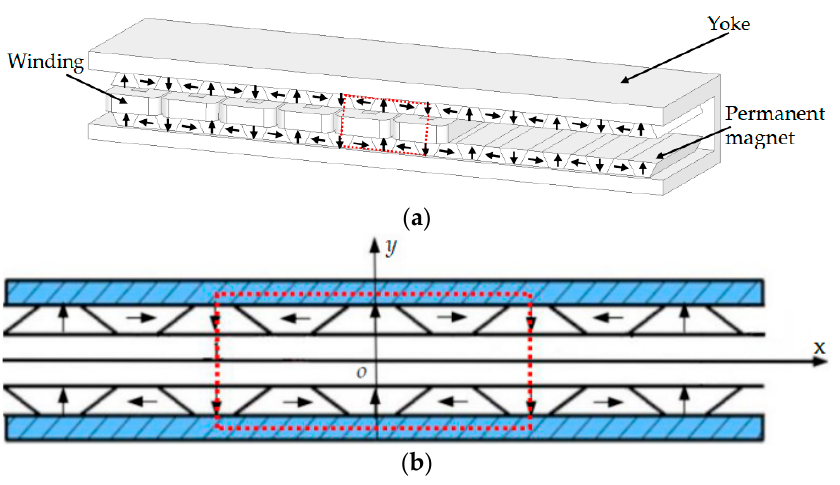
Figure 1. Topology of coreless PMLSM for trapezoidal Halbach permanent magnet array: ( a ) topol- ogy diagram of motor structure, and ( b ) schematic diagram of the two-dimensional structure of trapezoidal Halbach permanent magnet array.